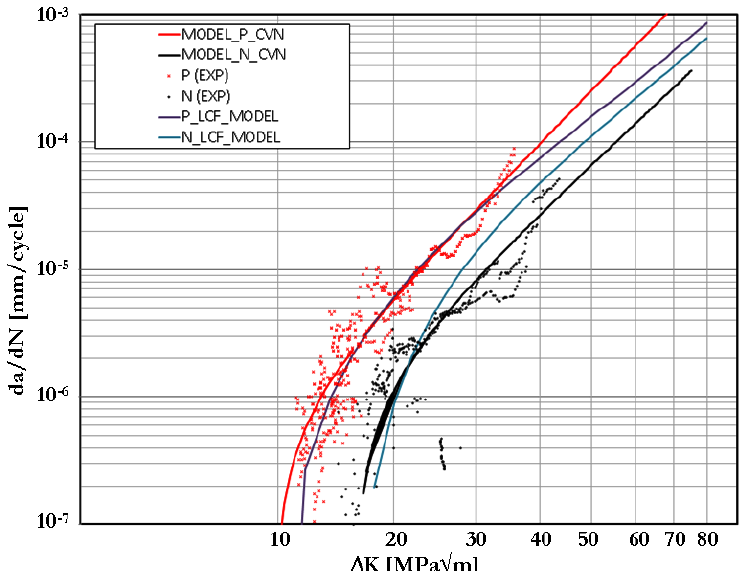
Figure 7: Fatigue crack growth rate for puddled steel (S) in post-operating state and normalized state, experimental data with proposed models